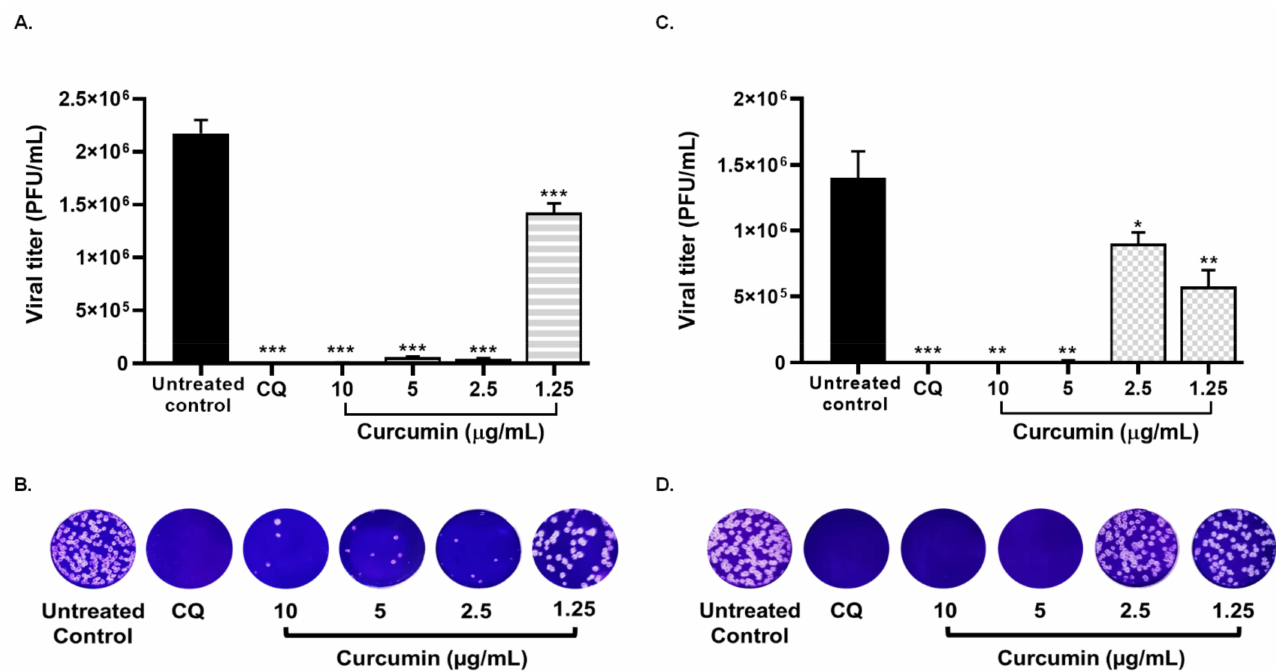
Figure 7. Treatment with curcumin inhibited the infection by SARS-CoV-2 Delta variant. ( A ) The figure represents the reduction of Delta variant titer (PFU/mL) on Vero E6 supernatants after pre–post infection treatment with curcumin (from 1.25 to 10 µ g/mL). Inhibition percentages of 99.8%, 98.4%, 98.9%, and 62.9% were obtained at 10, 5, 2.5, and 1.25 µ g/mL of curcumin, respectively. ( B ) Representative plaques on Vero E6 cells of the pre–post infection strategy of curcumin against SARS-CoV-2 Delta variant. ( C ) The figure shows the reduction of Delta variant titer (PFU/mL) on Vero E6 supernatants after co-treatment with curcumin (from 1.25 to 10 µ g/mL). Inhibition percentages of 99.9%, 99.1%, 31.9%, and 56.5% were obtained at 10, 5, 2.5, and 1.25 µ g/mL of curcumin, respectively. ( D ) Representative plaques on Vero E6 cells of the co-treatment of curcumin against SARS-CoV-2 Delta variant. Chloroquine (CQ) was used as a positive control of viral inhibition. Data were presented as median ± IQR (n = 4). Mann–Whitney test ** p ≤ 0.01, * p ≤ 0.05 . *** p ≤